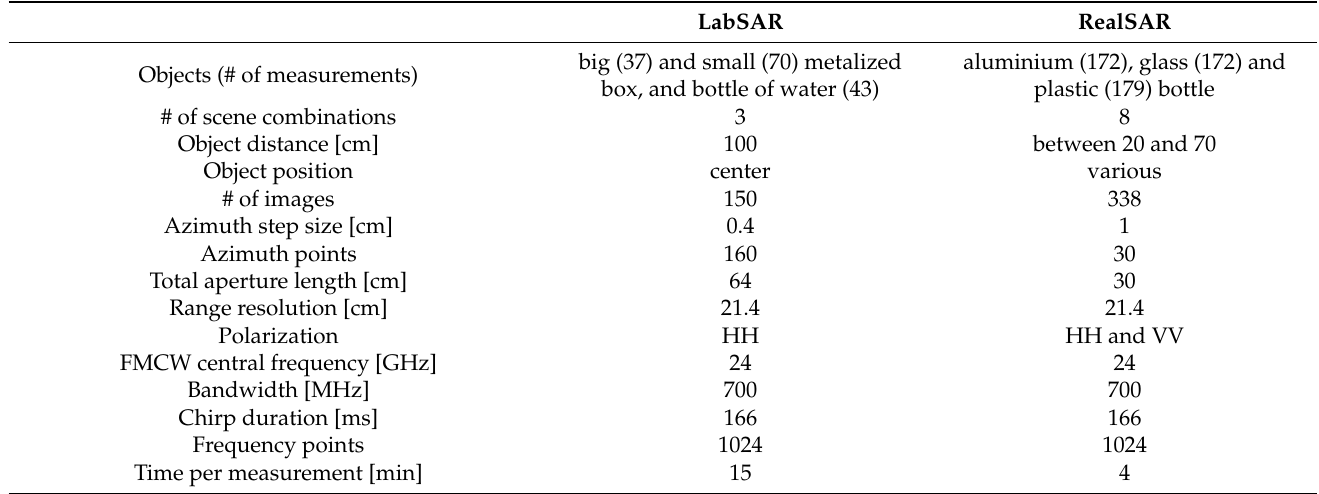
Table 1. LabSAR and RealSAR measurement set comparison. First five rows describe objects and scenes, while others GBSAR-Pi parameters used in the